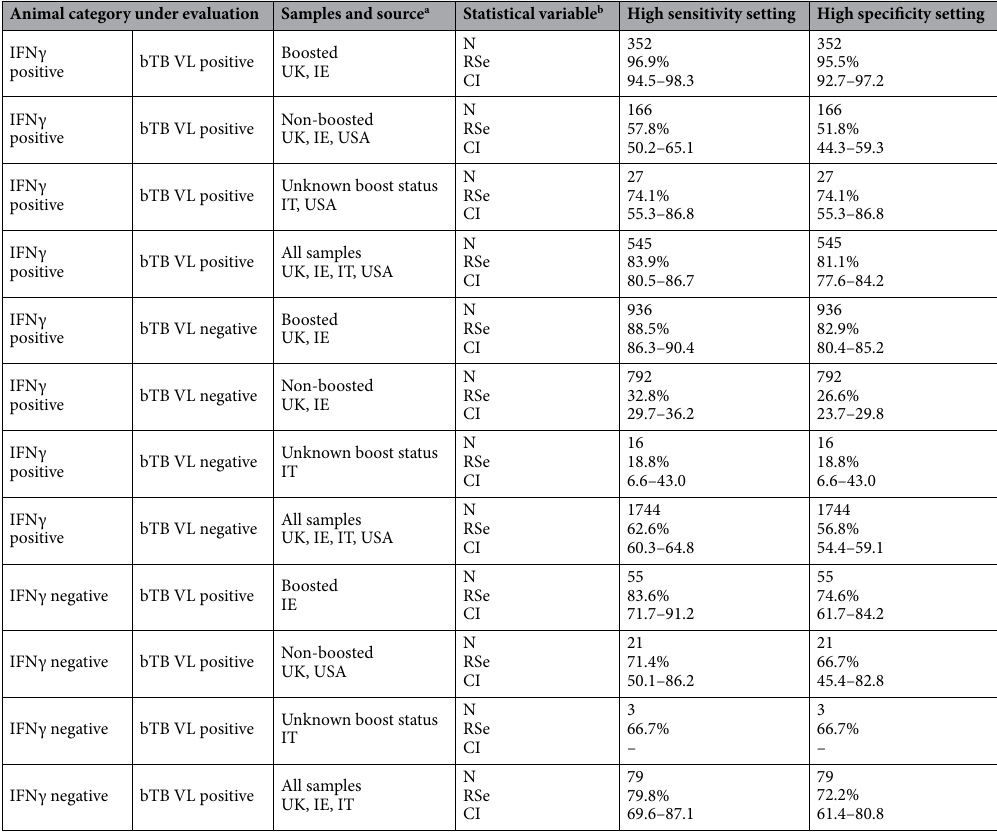
Table 6. Relative sensitivity of Enferplex Bovine TB antibody test in IFNγ positive animals with or without visible lesions. Diagnostic sensitivity was estimated at the high sensitivity and high specificity settings using reference sera from IFNγ positive animals showing bTB lesions at post-mortem. a Boosted- samples taken within anamnestic window; non-boosted—samples taken outwith the anamnestic window (5–30 days post tuberculin injection); United Kingdom (UK), Ireland (IE), Italy (IT); United States of America (USA). b N = number; RSe—relative sensitivity; CI—95% Confidence